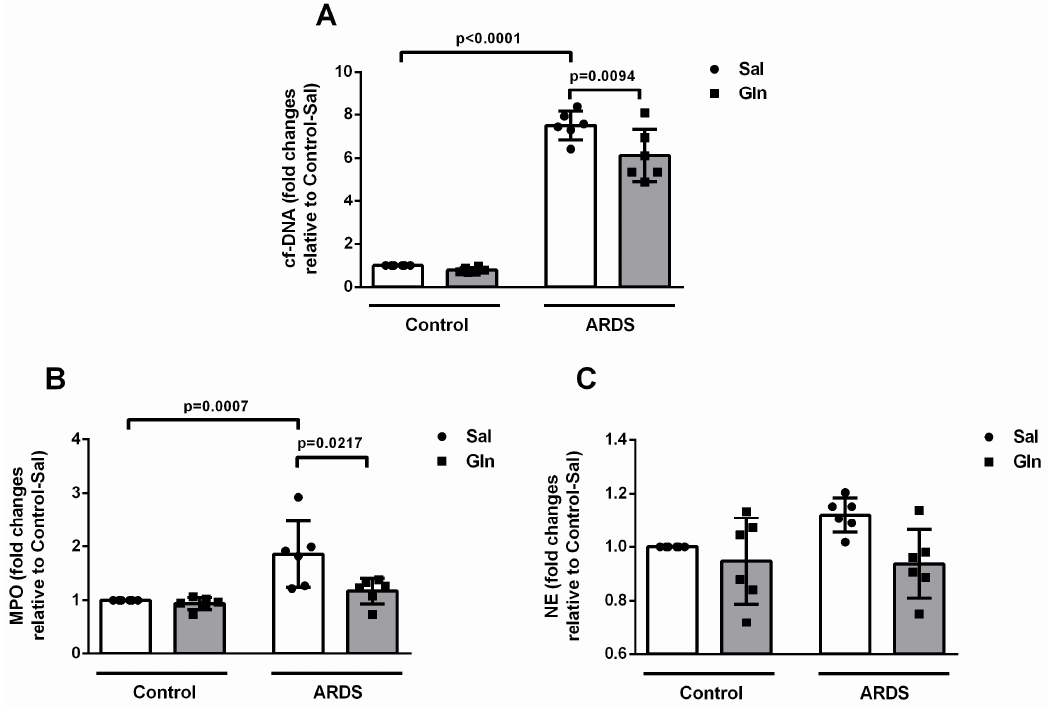
Figure 2. Glutamine decreased ET markers in bronchoalveolar lavage fluid (BALF) in a mouse model of pulmonary ARDS. ( A ) Cf-DNA was quantified using the PicoGreen assay kit in the supernatant from each sample obtained from BALF centrifugation. ( B ) Myeloperoxidase (MPO) activity was assayed in BALF supernatants incubated with hexadecyltrimethylammonium bromide (HTAB), tetramethylbenzidine (TMB), and hydrogen peroxide (H 2 O 2 ). ( C ) Neutrophil elastase (NE) activity was measured in BALF supernatants incubated with N-methoxysuccinyl-Ala-Ala-Pro-Val-7-amido-4-methylcoumarin. Values normalized in relation to Control-Sal are expressed as mean ± SD of six animals in each group. Symbols represent individual animals. Experiments were performed in triplicate. The data shown are from a single representative experiment.